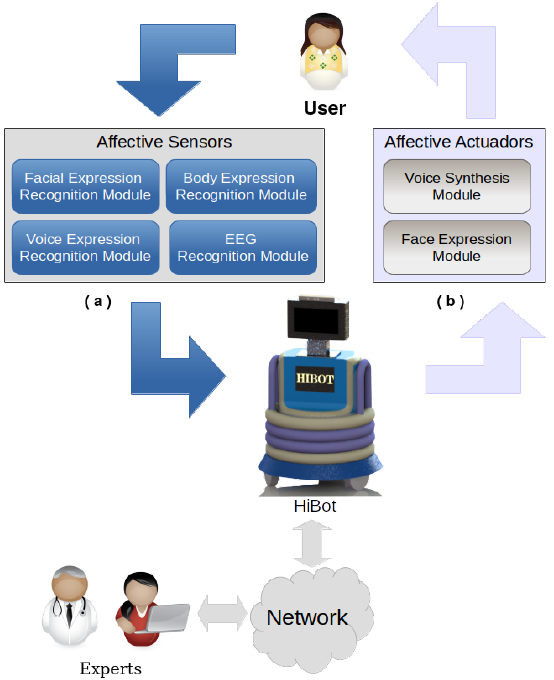
Figure 1. HiBot’s architecture. ( a ) Affective Sensors: responsible to obtain affective cues transmitted by different modals and ( b ) Affective Actuators: responsible to promote interaction through social